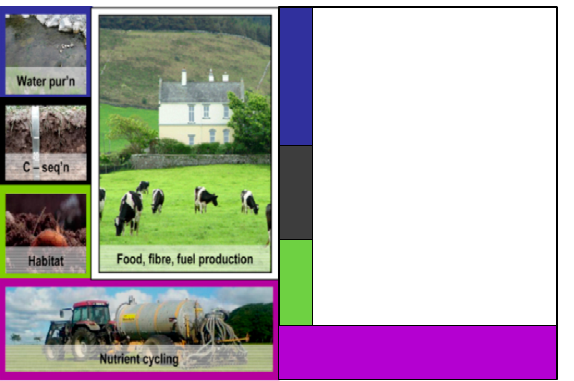
Figure 3. The supply matrix of cultivated land soil function (Adapted with permission from ref. [70]. Copyright 2016 Copyright Coyle, et